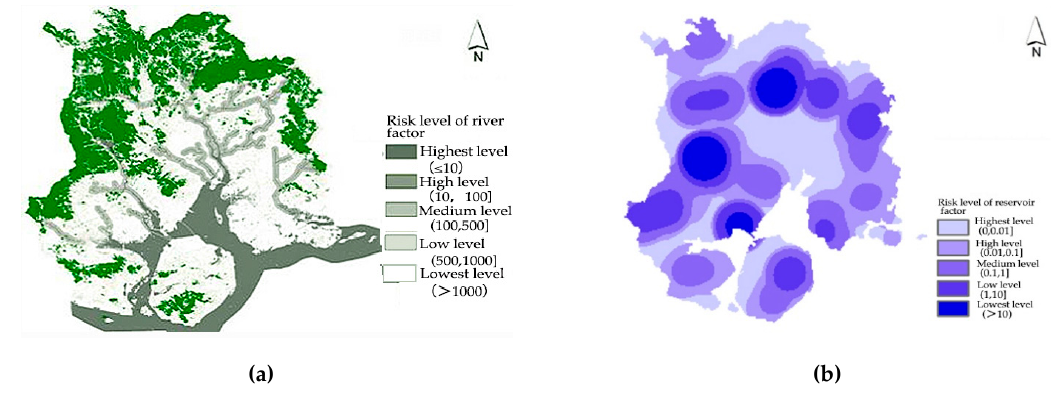
Figure 3. Analysis of flood factors in Xiamen: ( a ) analysis of river buffers; and ( b ) analysis of reservoir buffers.